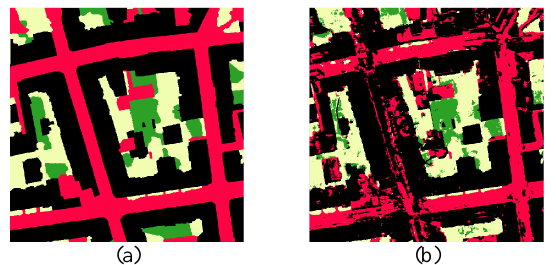
Figure 5. GRAZ dataset: Ground truth (a) and classified data using 9x9 neighborhood features ( T = 50 , D = 15). Please note that this depicted result is “biased” - in order to produce the classified image, the classifier has been tested on the whole dataset (including subset for training) (b)